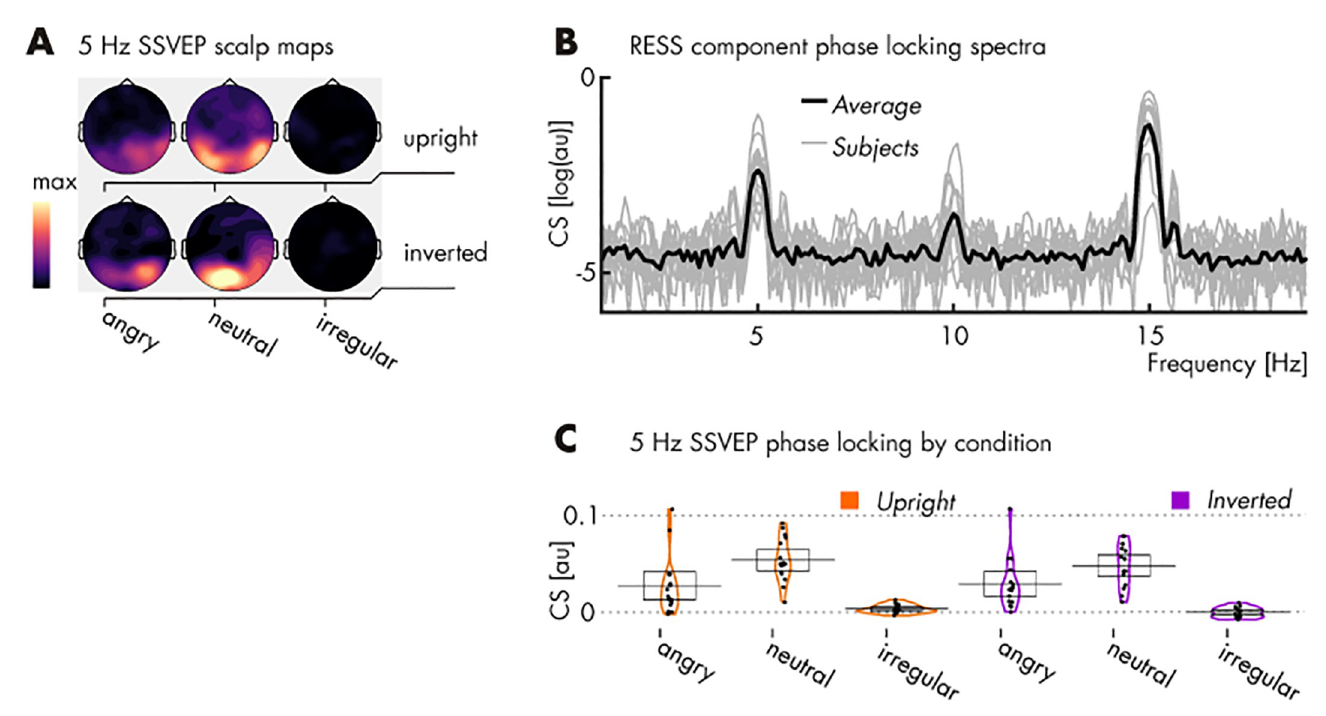
Fig 2. Spectral characteristics of EEG responses to stimulation in Pilot 1 . ( A ) Topographical distributions of phase-locking, quantified as the cosine similarity (CS) index, at the regularity frequency of 5 Hz. Note the lack of phase-locking, i.e., consistent responses to the irregular stimulation conditions (maps use the same scale, in arbitrary units); ( B ) CS index of phase locking across the EEG spectrum (arbitrary scale) with the group average superimposed on single subject spectra, based on RESS spatial filter projections and collapsed across conditions featuring a regular presentation (i.e., excluding irregular stimulation conditions for their lack of signal; see panel A ). For visualization only, CS has been converted to log(CS). ( C ) CS at the regularity frequency for each participant (single dots) and condition. Mean values are marked by horizontal black lines and 95% confidence intervals represented as transparent boxes. See Table 3 for specific results of statistical